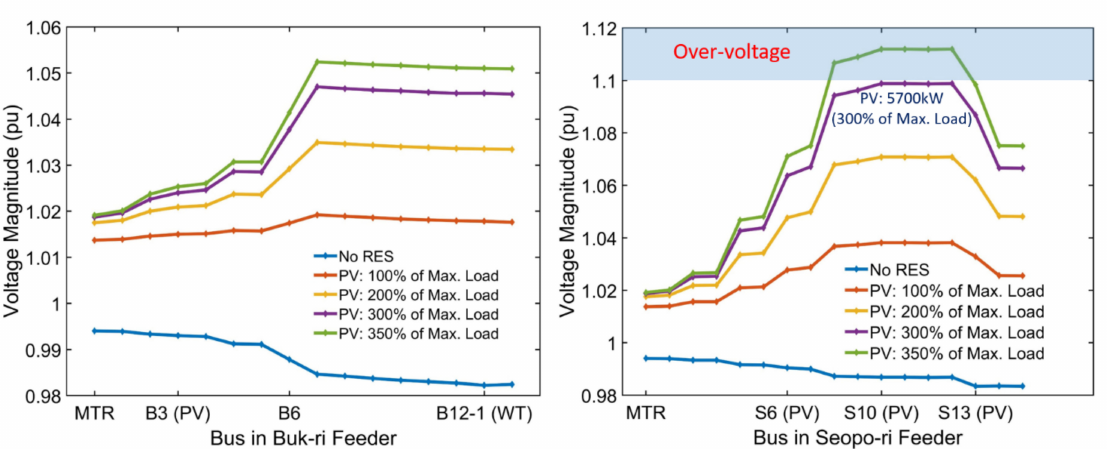
Figure 19. System voltage profile under minimum load and different PV generation levels considering power system reconfiguration.